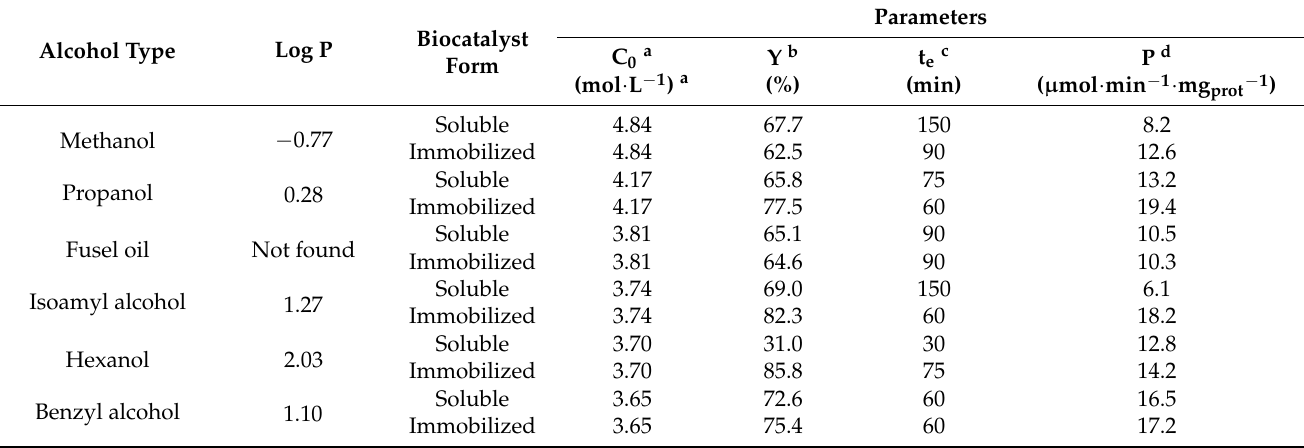
Table 3. Estimation of productivity for the production of several octanoate esters catalyzed by soluble and immobilized lipase Eversa ® Transform